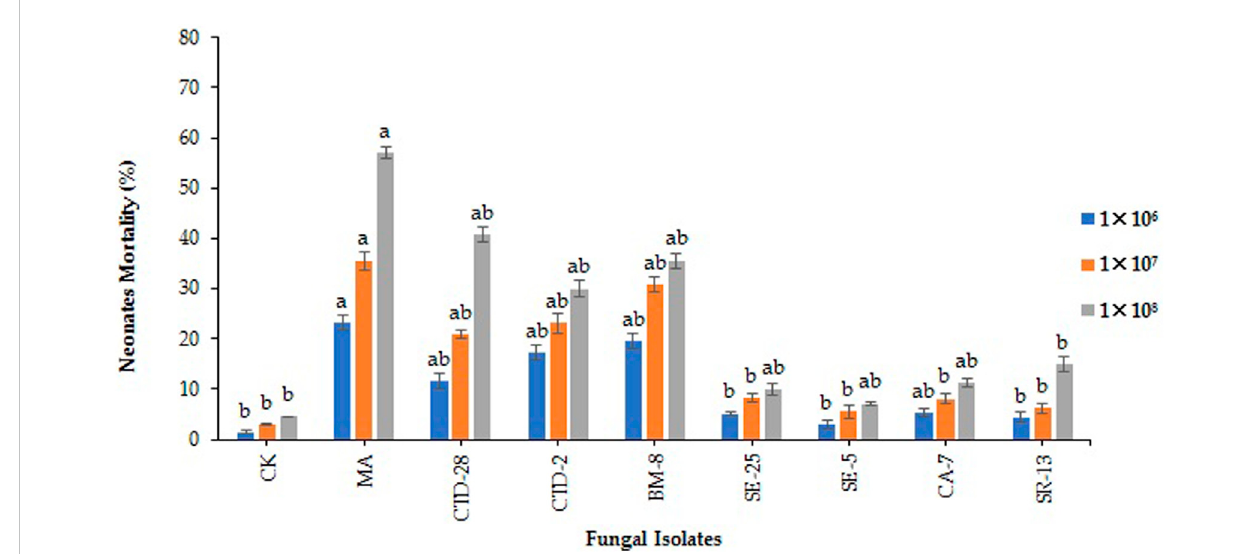
FIGURE 2 Fungal isolates induced fall armyworm ’ s neonate larvae mortality when treated with different concentrations at 7 days post treatment. Error bars denote the mean ± standard error at the 95% con fi dence interval. Means followed by the same letters are not signi fi cantly different by Tukey ’ s test at p < 0.05.